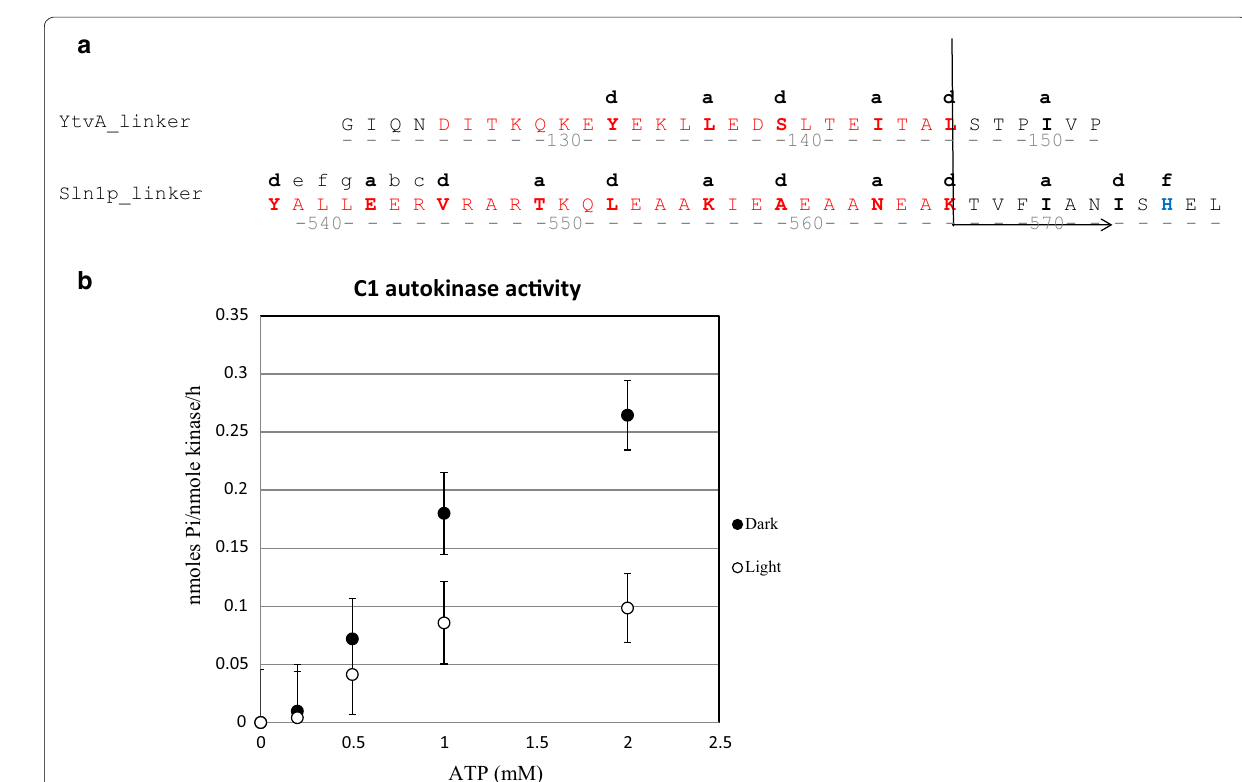
Fig. 2 a Alignment of the coiled coil structures from Sln1 and YtvA. The point of switching over from the amino acid sequence of the Jα helix of YtvA to the Sln1 sequence in the C1 construct is indicated by the arrow. b Effect of light on the incorporation of [ 32 Pi] into the C1 histidine kinase fusion protein. [γ- 32 P]-ATP was used as the phosphoryl group donor. Reaction mixtures were incubated either in the presence of light (open sym- bols) or in the dark (filled circles). Error bars represent the standard deviation calculated from three independent experiments. For further detail: see Materials and